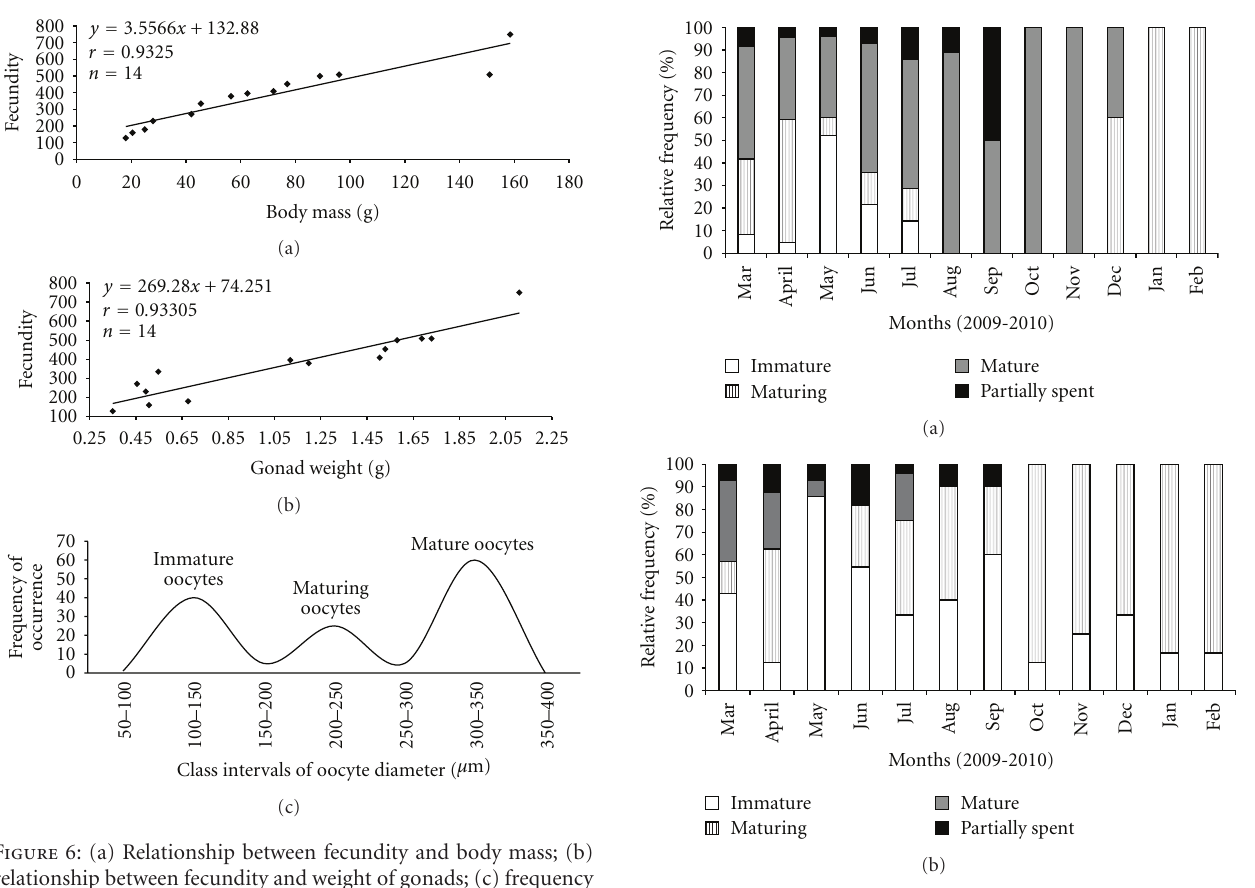
Figure 7: Monthly frequency of occurrence of gonadal maturity stages of C. menezesi (a) females and (b)